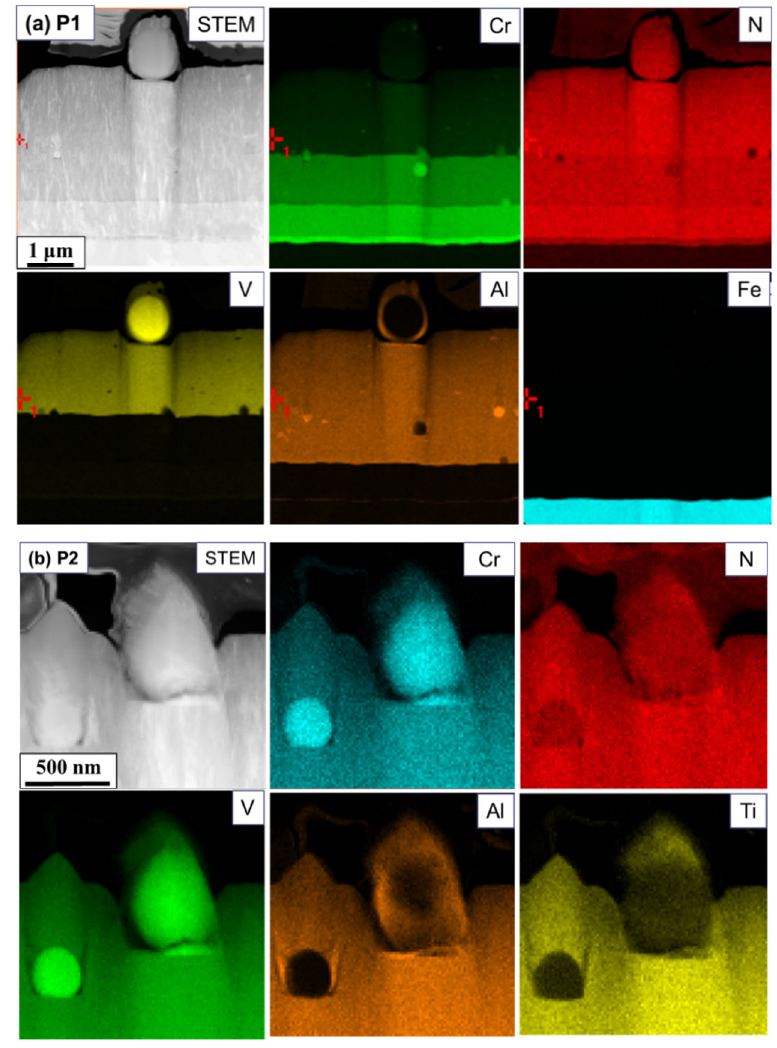
Figure 6. Images of cross-section of P1 ( a ) and P2 ( b ) hybrid coatings with accompanying EDS maps presenting distribution of Cr, Al, Ti, V, N.